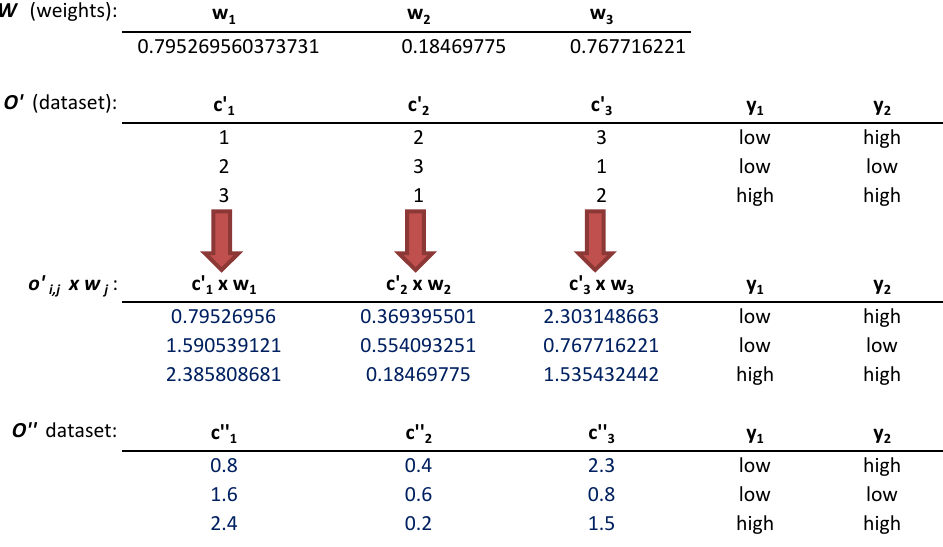
Figure 2. Weighting dataset and rounding to the